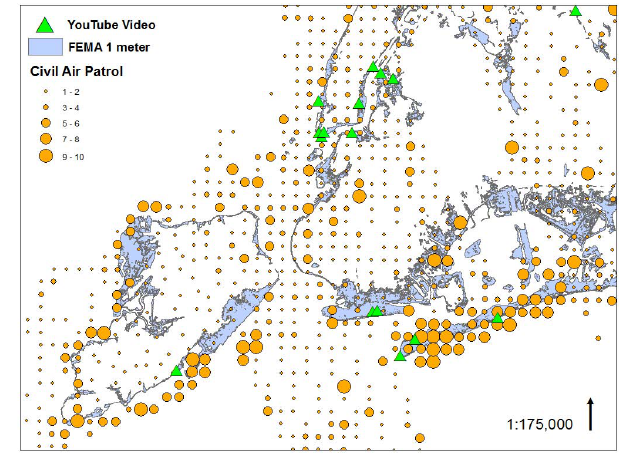
Fig. 6. Example of YouTube video documenting flooding.